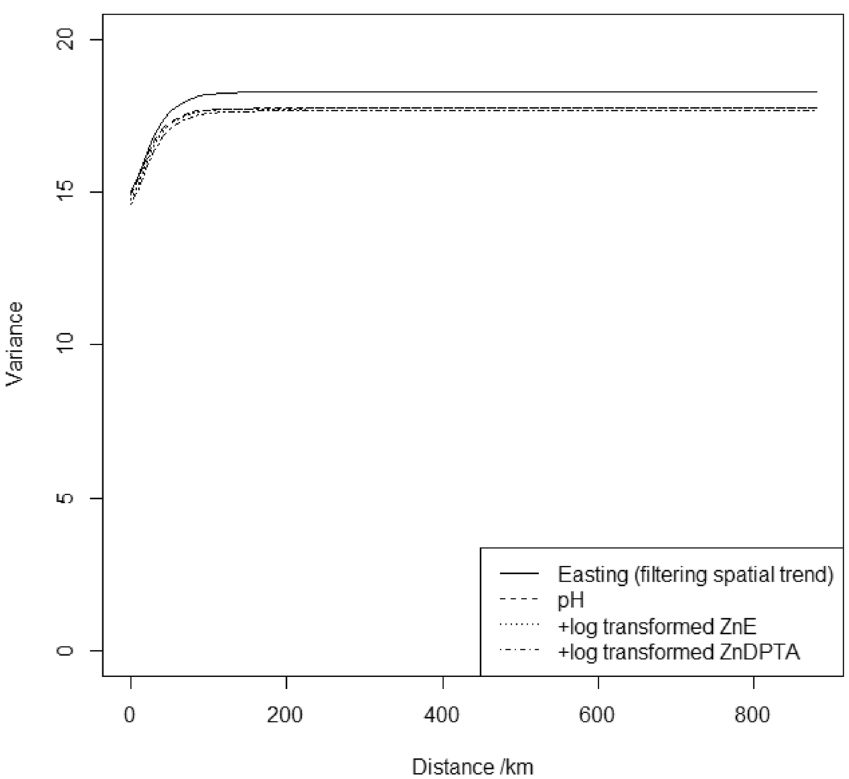
Figure 2. Variogram functions for the null model (eastings only) for maize grain zinc concentration, and for successive models with selected soil properties added as